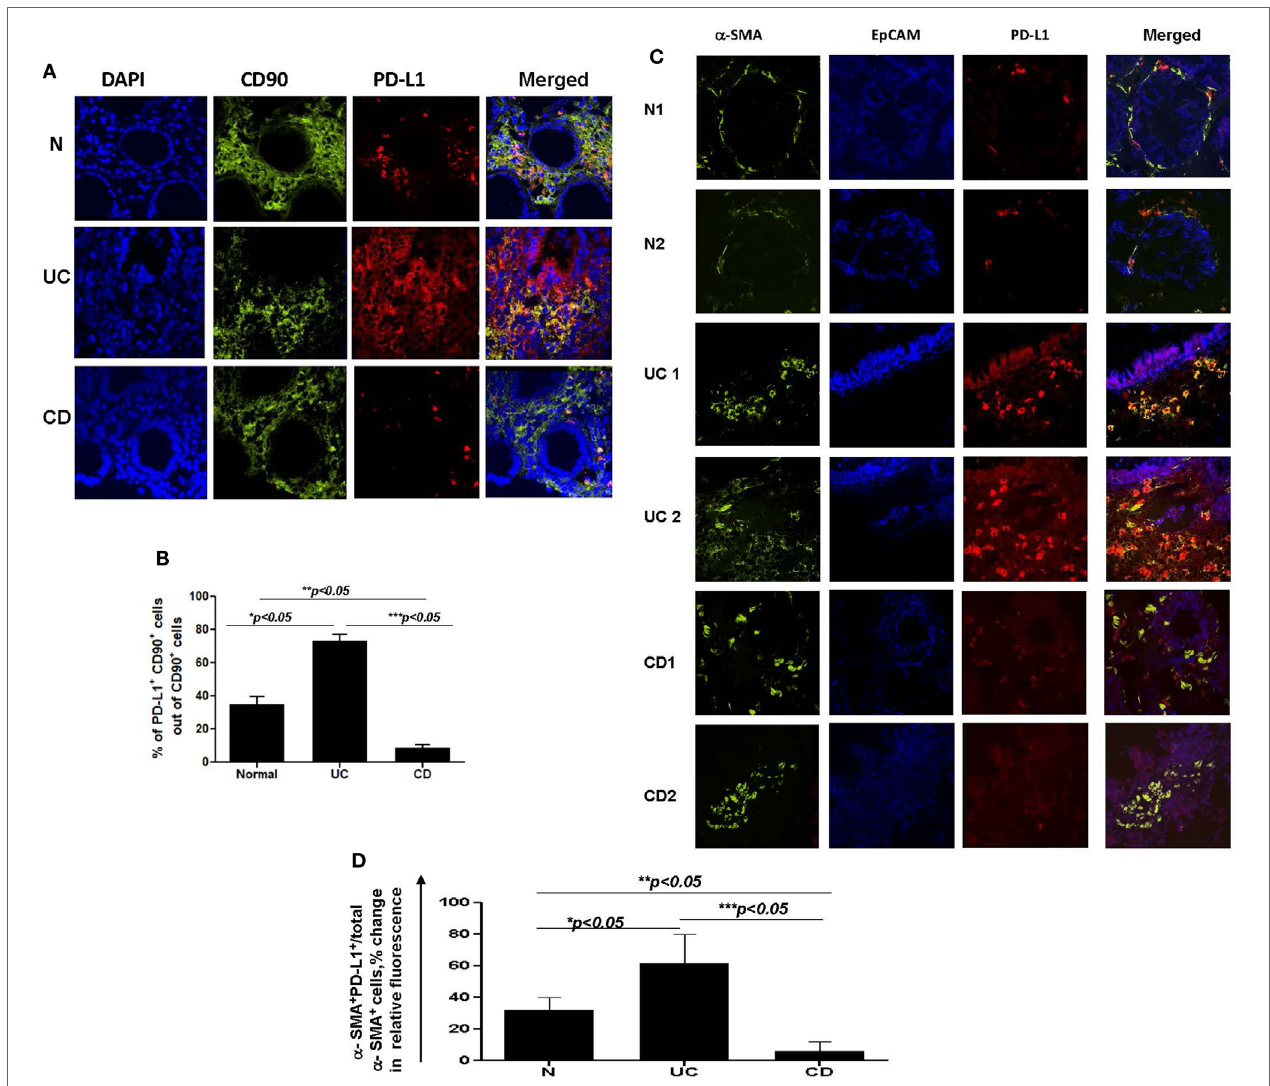
FigUre 3 | (a) The number of programmed death-ligand 1 (PD-L1) expressing CD90 + mesenchymal cells is increased in ulcerative colitis (UC) and decreased in Crohn’s disease (CD) colonic mucosa. Confocal microscopy analysis of a representative cross sections of UC, CD, and normal human colonic mucosa ( n = 10 per group) were performed. Cell nuclei (in blue) were stained with DAPI. CMFs may be identified by morphology, lamina propria location, and staining with anti-human CD90 monoclonal antibodies (mAbs) conjugated to AF ® 488 (clone 5E10, in green). PD-L1 staining (in red) was performed using AF ® 633-labeled anti-PD-L1 human mAbs (clone MIH1). Co-localization of PD-L1 within CD90 + CMFs shown in yellow-orange (arrow) on merged images. (B) Summary of changes in the PD-L1 expression by CD90 + CMFs in situ . Image J software was used for the quantification analysis as described in Section “Materials and Methods.” Data were expressed as means ± SEM of percentage of the changes in the count of corrected total cell fluorescence (CTCF) of PD-L1 positive CD90 + cells (yellow-orange color formation) over total CD90 + CMFs (both, green and yellow-orange stained cells), n = 10 per group, *p < 0.05 . (c) Changes in PD-L1 expression in mesenchymal stromal cells of inflamed inflammatory bowel disease colonic mucosa are mainly associated with α -smooth muscle actin ( α -SMA + ) myofibroblasts. Confocal microscopy images of two representative cross sections from UC, CD, and normal human colonic mucosa ( n = 7 per group) are shown. Activated fibroblasts(myofibroblasts), were detected by anti- α -SMA mAb (green), and epithelial cells were identified with anti-EpCAM mAb (in blue). Co-localization of PD-L1 with epithelial cells and α -SMA + myofibroblasts results in formation of magenta and yellow-orange color, respectively, on merged images. (D) Summary of